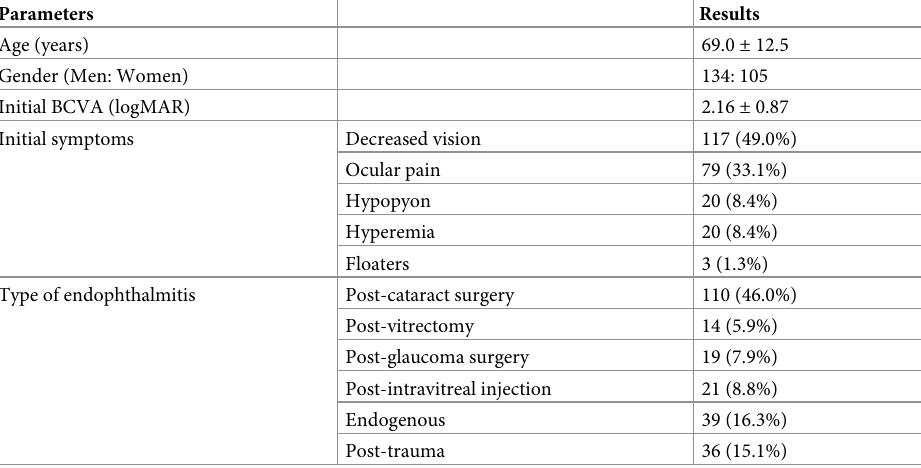
Table 1. Demographics of patients with infectious